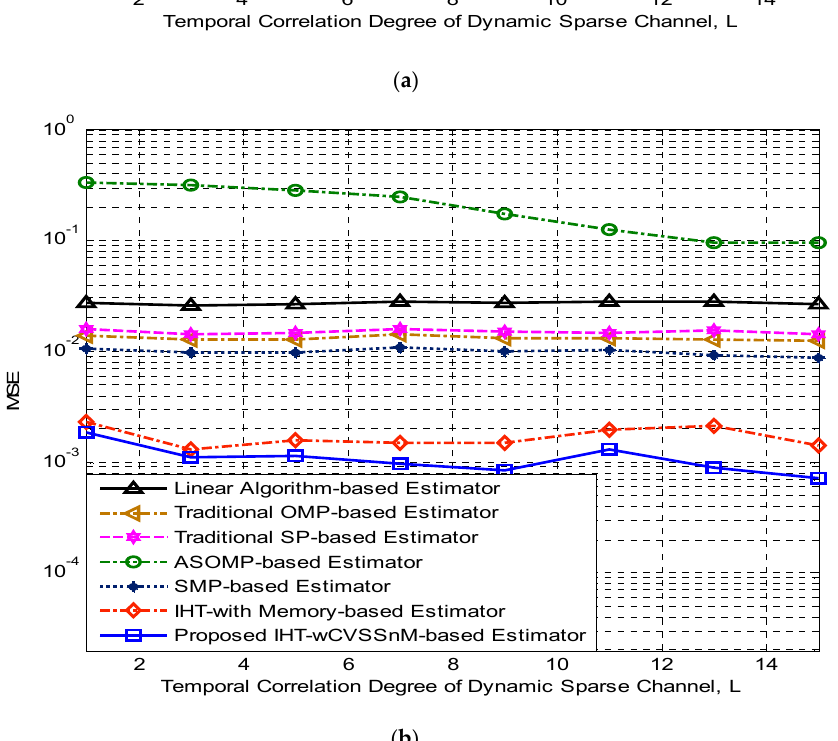
Figure 3. Achievable comparative MSE versus temporal correlation degree of dynamic sparse channel performance of the proposed IHT-wCVSSnM-based estimator with other channel estimators ( a ) SNR = 5 dB, ( b ) SNR = 15 dB.